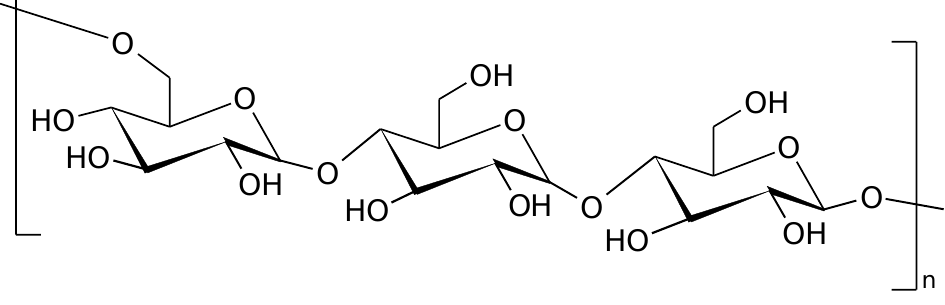
Figure 8. The fragment of pullulan